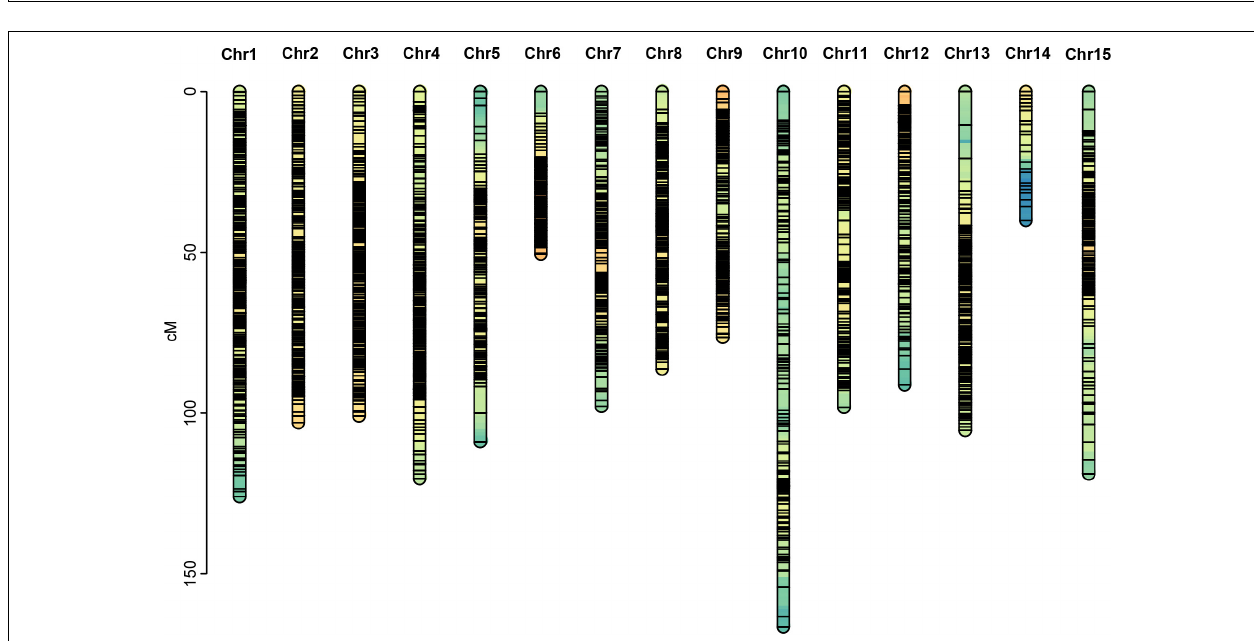
FIGURE 2 | Segregation of SNPs that could be used for genetic map construction.